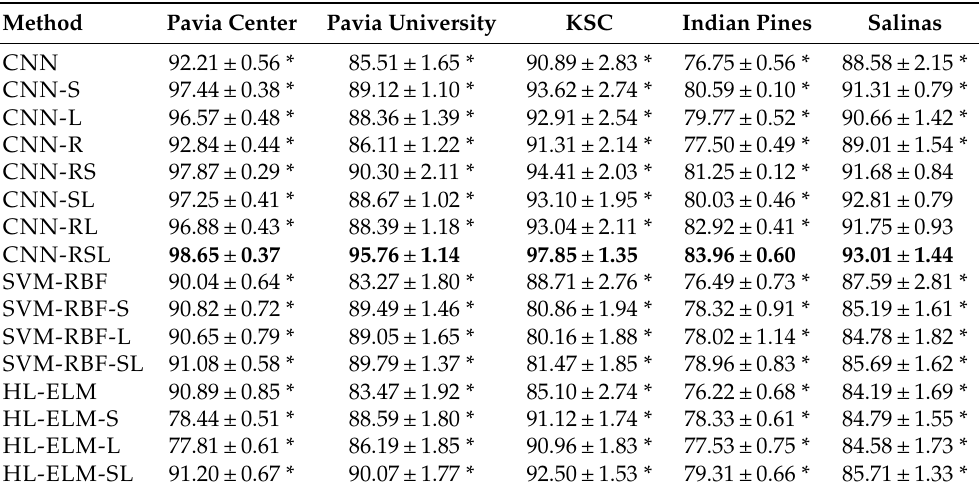
Table 8. Average classification accuracy of test data over 10 runs using 10 randomly sampled labeled pixels per class for training. The best accuracy for each dataset is indicated in bold. An ‘*’ means that the best accuracy is significantly better than the accuracy achieved by the corresponding method according to a binomial test for comparing classifiers [45] ( p -value <